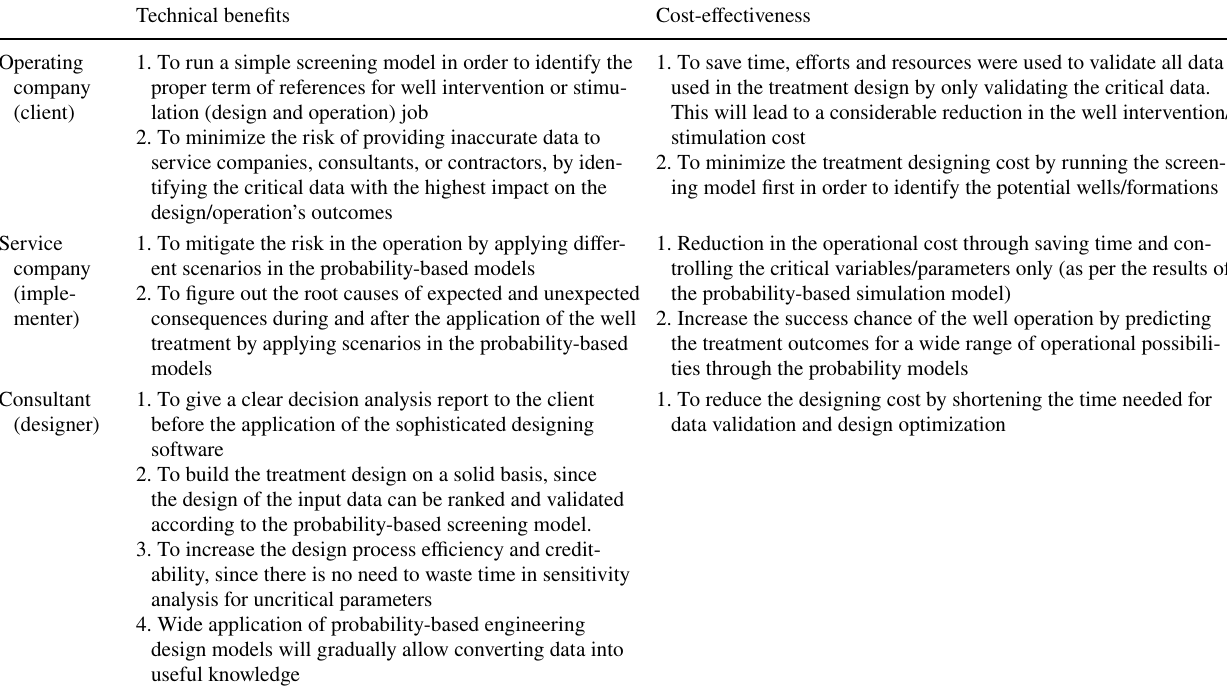
Table 1 Technical and commercial benefits of utilizing the VBSA in both design and operational activities Technical benefits